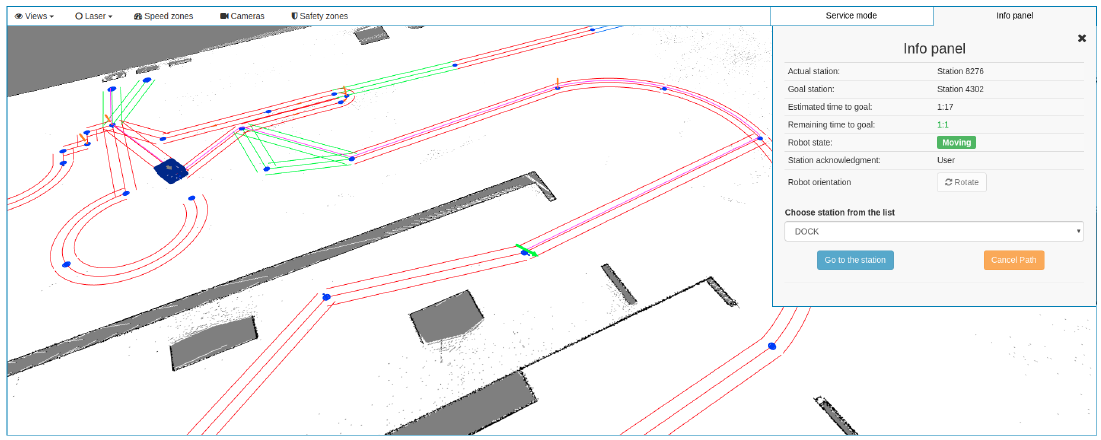
Figure 9. An example of a predefined trajectory